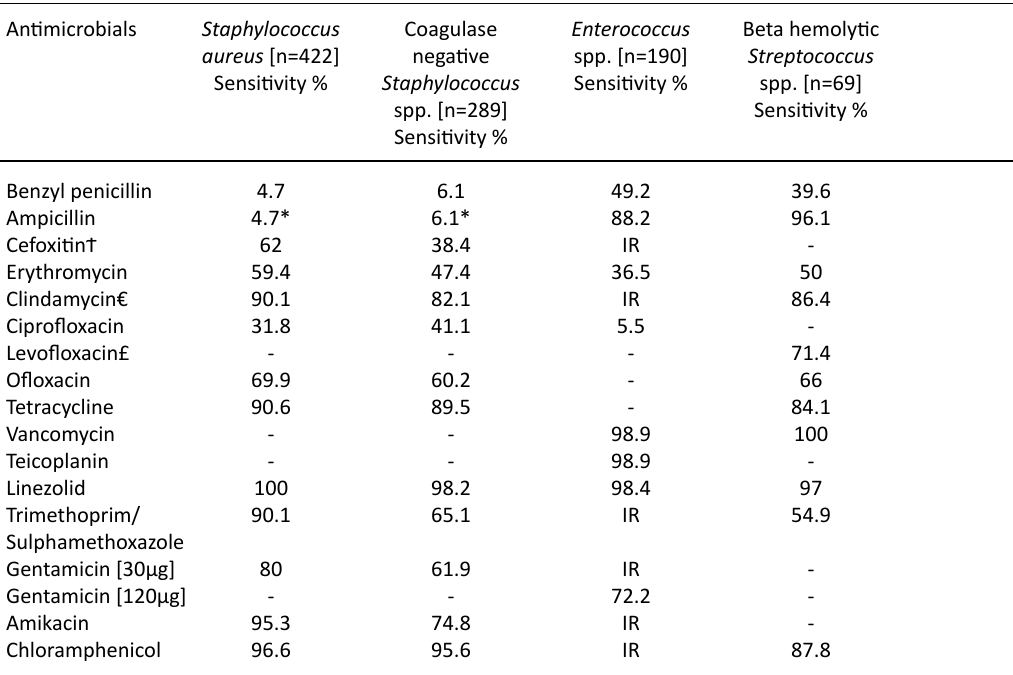
Table 2. Antibiotic susceptible pattern of Gram-positive cocci analyzed in the study Antimicrobials Staphylococcus